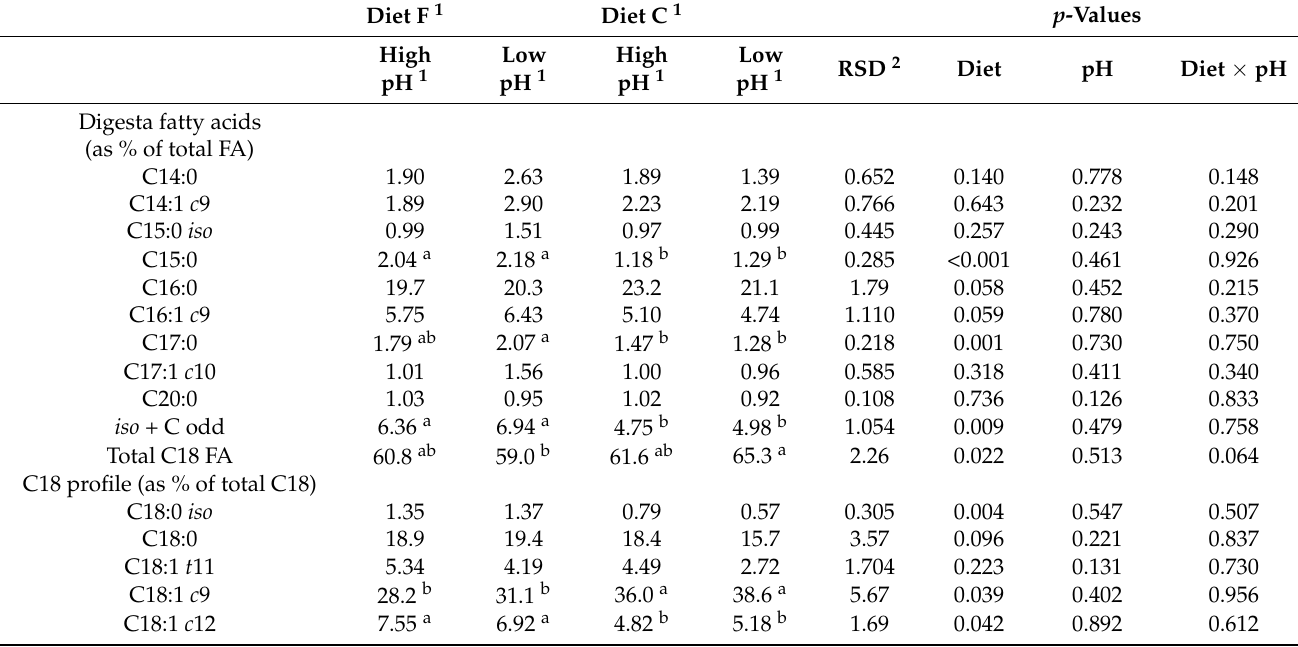
Table 4. Effect of diet and pH in the medium (high or low) on fatty acid (FA) profile and hydrogenation in rumen digesta from continuous cultures. Diet F 1 Diet C 1 p